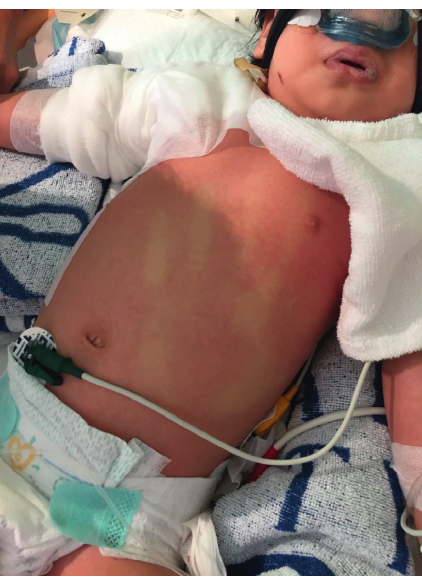
Figure 2: Deteriorated central capillary refill with palm mark on the